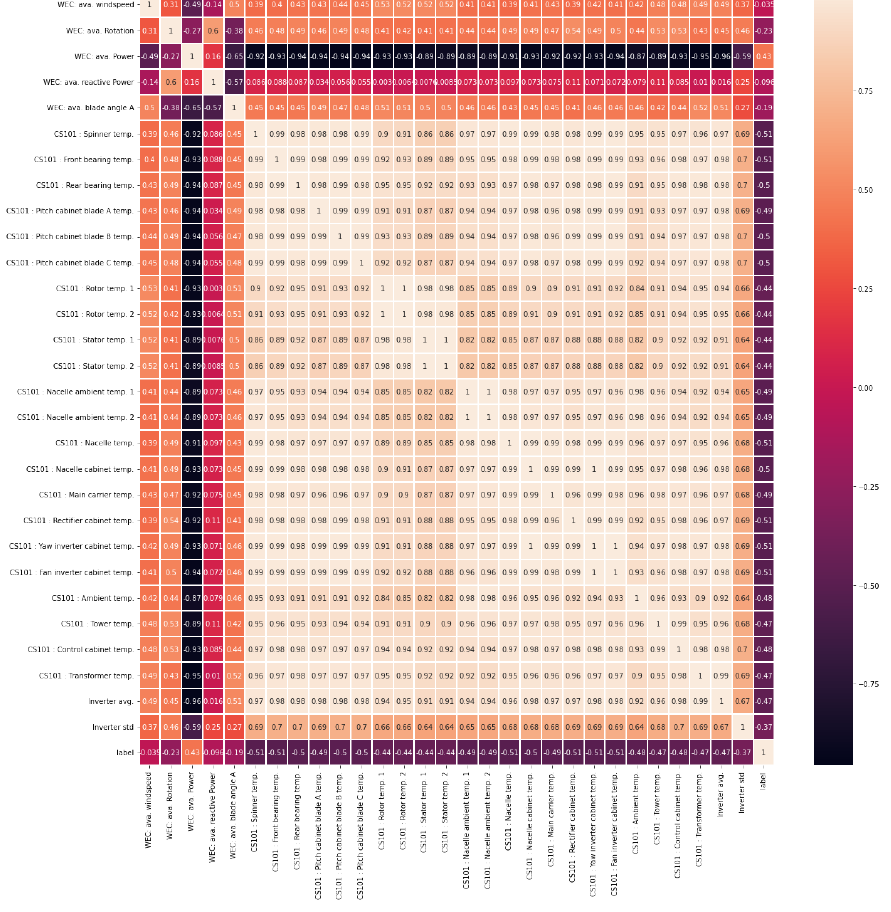
Figure A1. Correlation diagram of